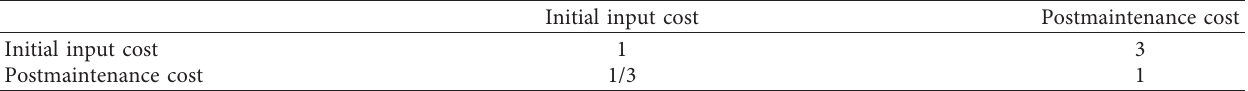
Table 13: Index scale table of the economic control effect plan.